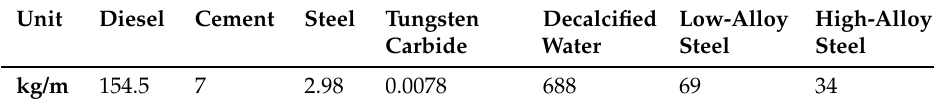
Table 4. Materials used for the “variable” part of a geothermal station in kg per meter depth. Unit